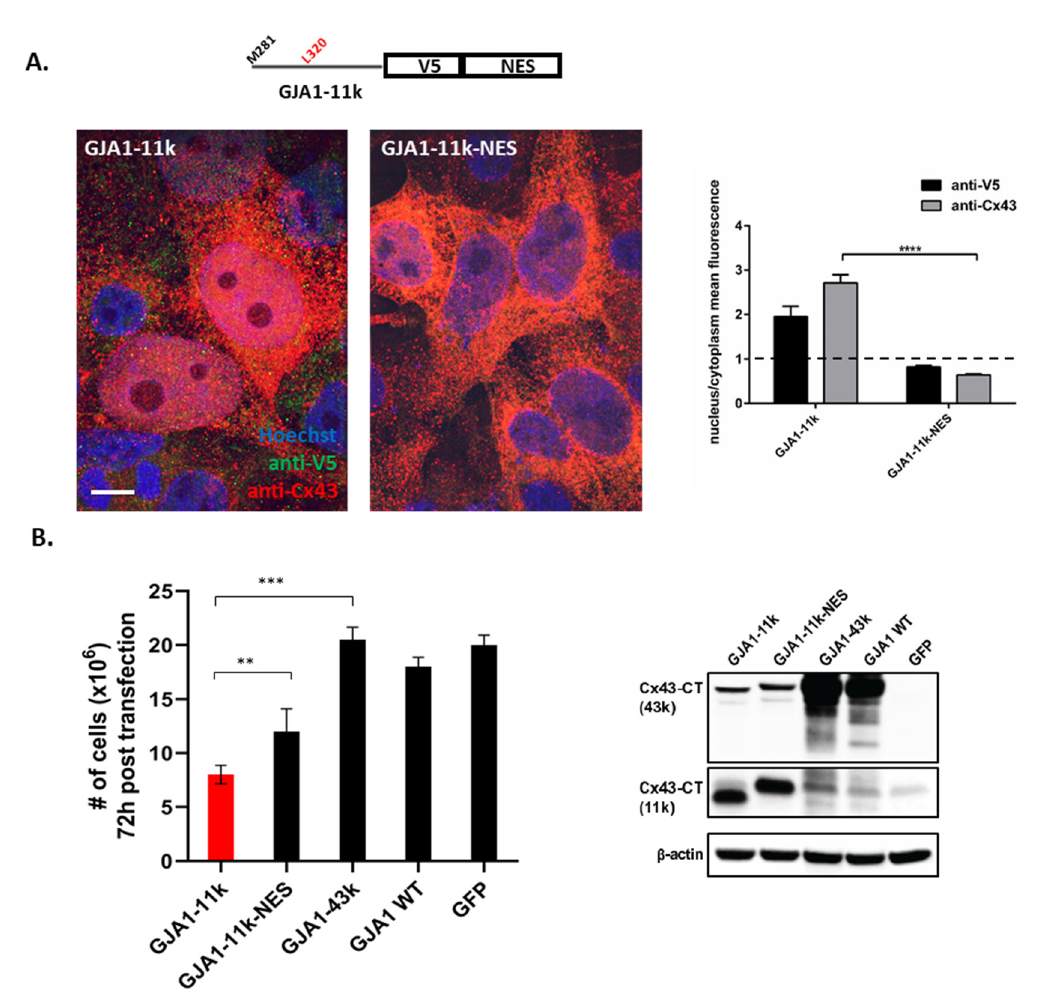
Figure 5: GJA1-11k with nuclear export signal rescues the cell proliferation of the HEK293FT cell line. ( A ) . The immunofluorescence of HEK293FT cells expressing GJA1-11k or GJA1-11k-NES probed with V5 and Cx43 antibodies (Sigma) and the corresponding ratio of fluorescence density in the nucleus versus cytoplasm is shown on the graph. Scale bar: 10µm. The graph results are representative of four independent experiments. The data are presented as mean ± SEM, n = 26, **** p < 0.0001 by an unpaired two-tail Student’s t test. The intensities in the bar graph were measured and normalized to background using Image J. ( B ) . GJA1-11k-NES rescues cell proliferation, suggesting that the effect of GJA1-11k is linked to the nucleus. The number of cells transiently transfected with vectors expressing GJA1-11k, GJA1-11k-NES, GJA1-43k, GJA1-WT, and the negative control plasmid GFP were counted 72 h after transfection. Cell growth analysis has shown that cells expressing GJA1-11k-NES grew significantly faster than cells expressing GJA1-11k. The Western Blot confirmed the transient expression of Cx43 isoforms. The data are presented as mean ± SEM, n = 12, ** p < 0.01, *** p < 0.001 by one-way ANOVA followed by Tukey’s post-hoc test.